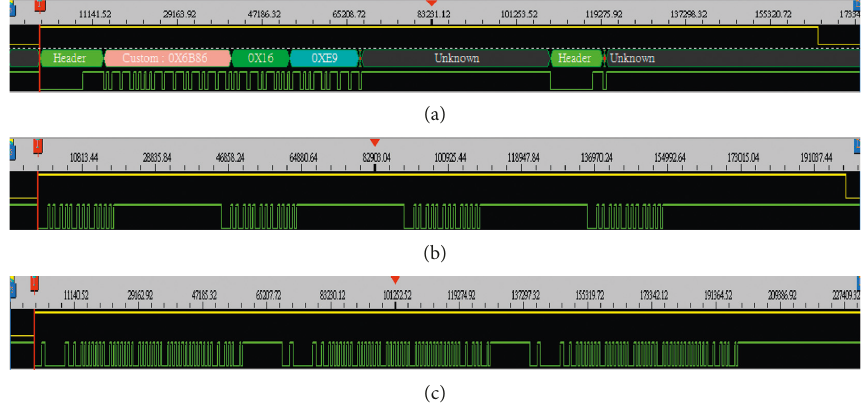
Figure 4: IR signals of (a) Terasic evaluation board, (b) SONY television, and (c) IRIS ceiling